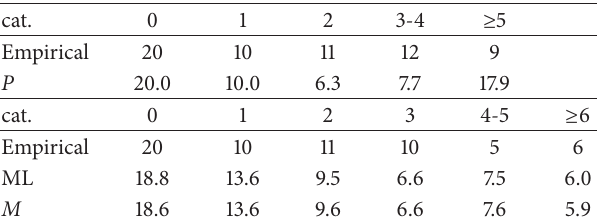
Table 5: Empirical and theoretical frequency distributions for the first example dataset.